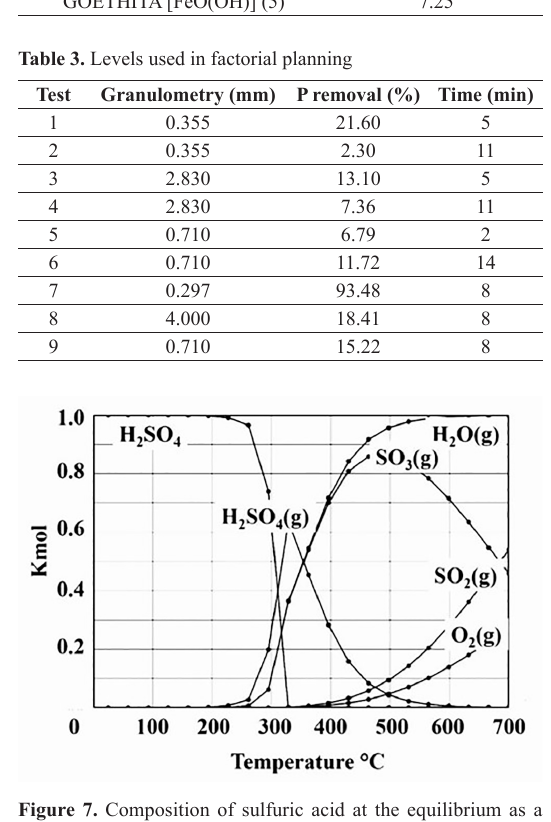
Figure 7. Composition of sulfuric acid at the equilibrium as a function of temperature using the HSC Chemistry  7.1 equilibration modulus (sulfuric acid at 1 kmol, total pressure: 1